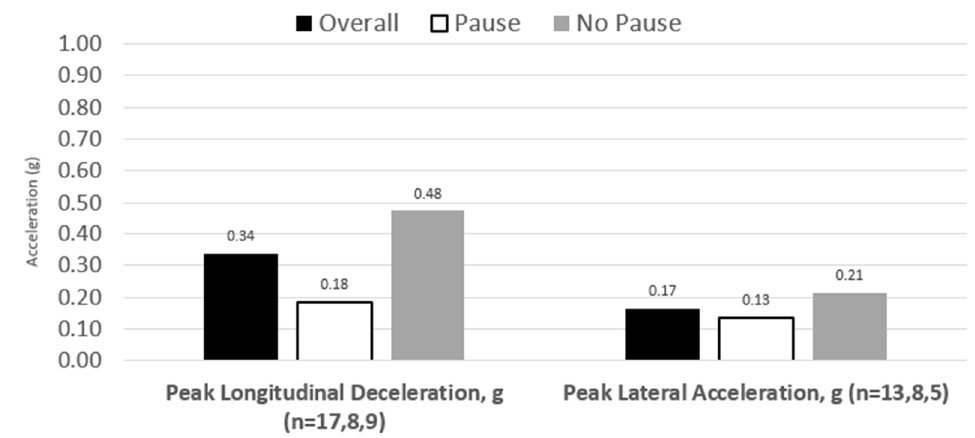
Figure 10. Mean driver response magnitude: Peak lateral and longitudinal acceleration associated with the drivers’ avoidance response.